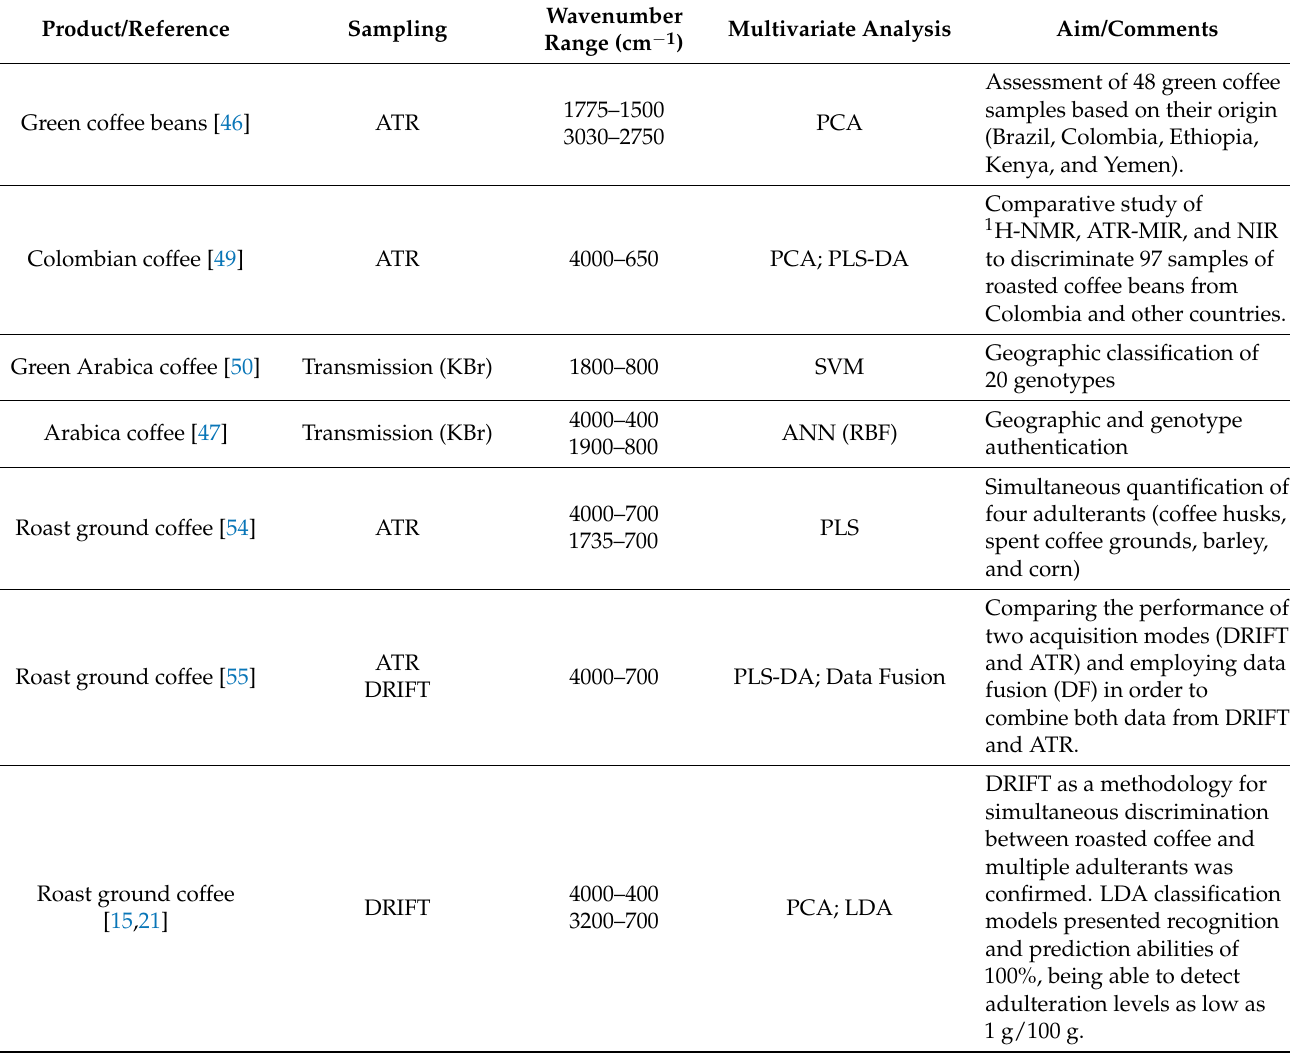
Table 1. Application of FT-MIR spectroscopy to the analysis of